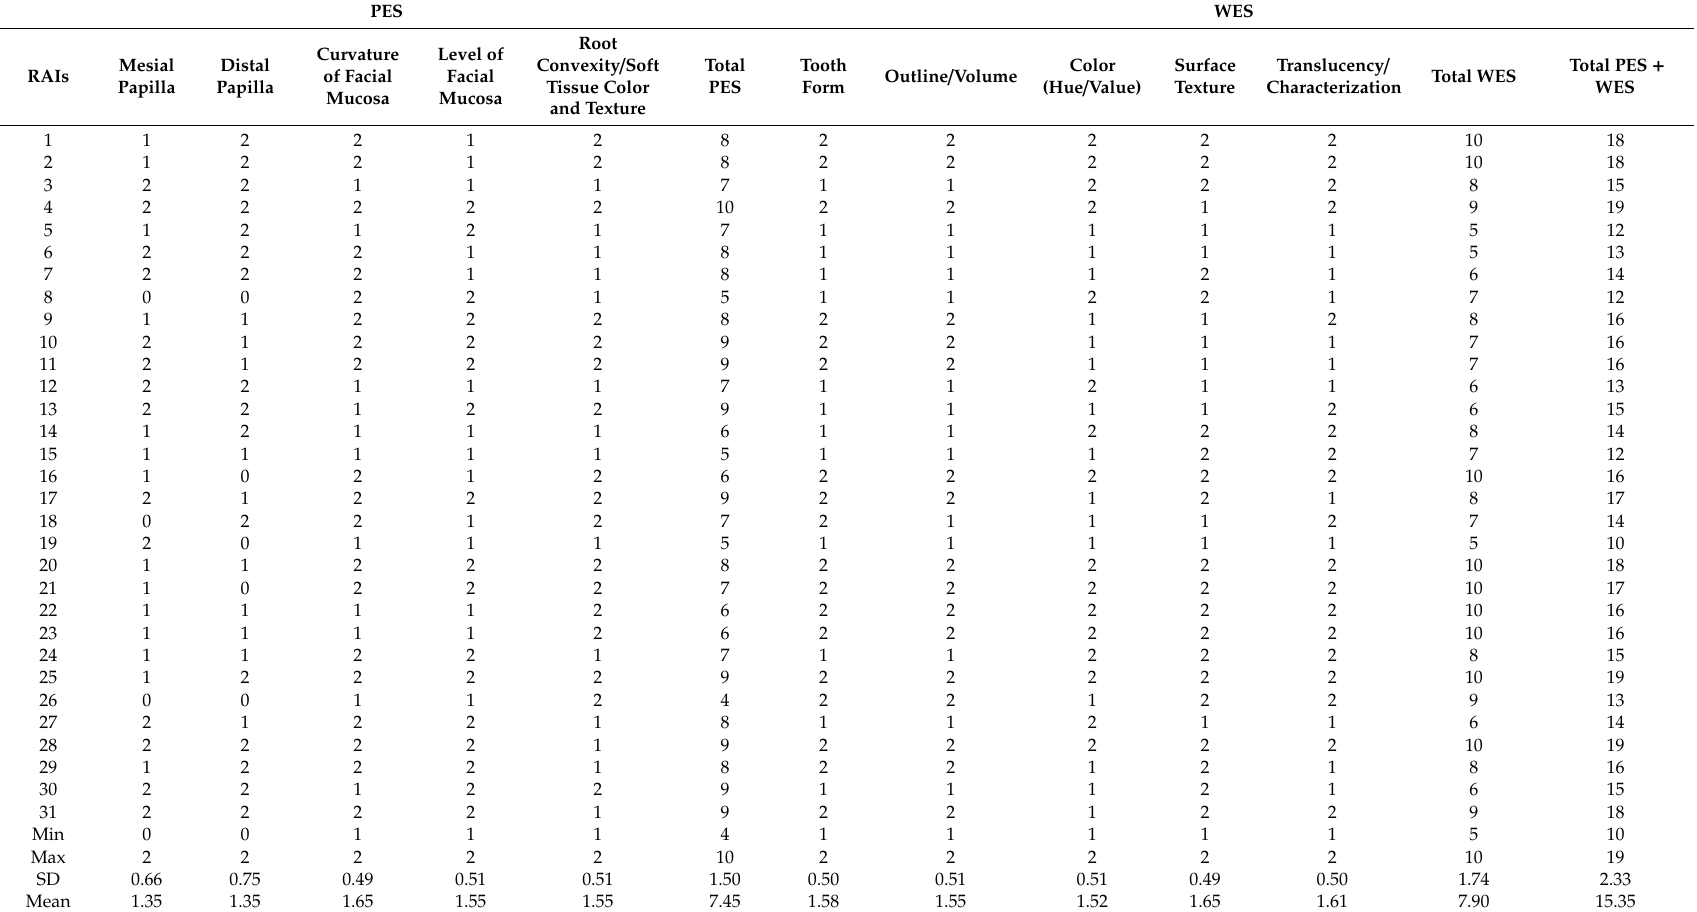
Table 9. Detailed Pink Esthetic Score (PES) and White Esthetic Score (WES) for each RAI investigated